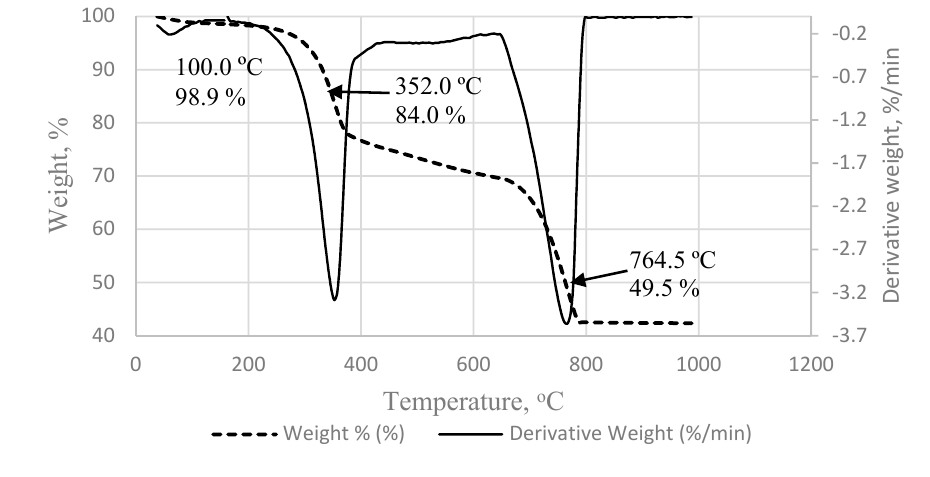
Figure 1. Thermal analysis of